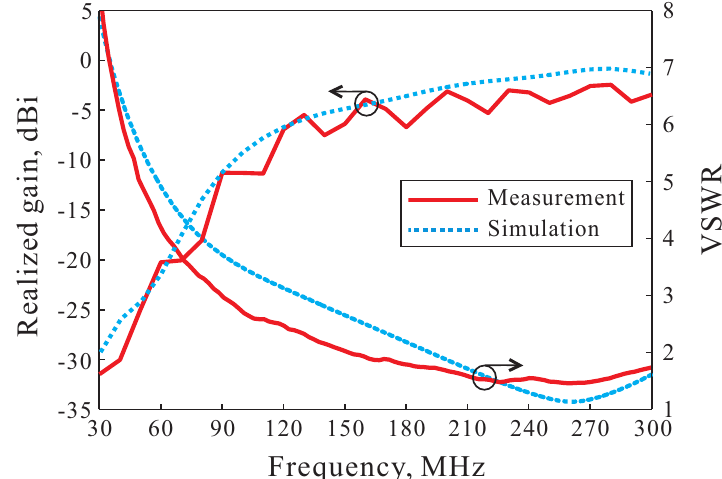
Figure 6. Simulated and measured Voltage Standing Wave Ratios (VSWRs) and realized gains of the proposed